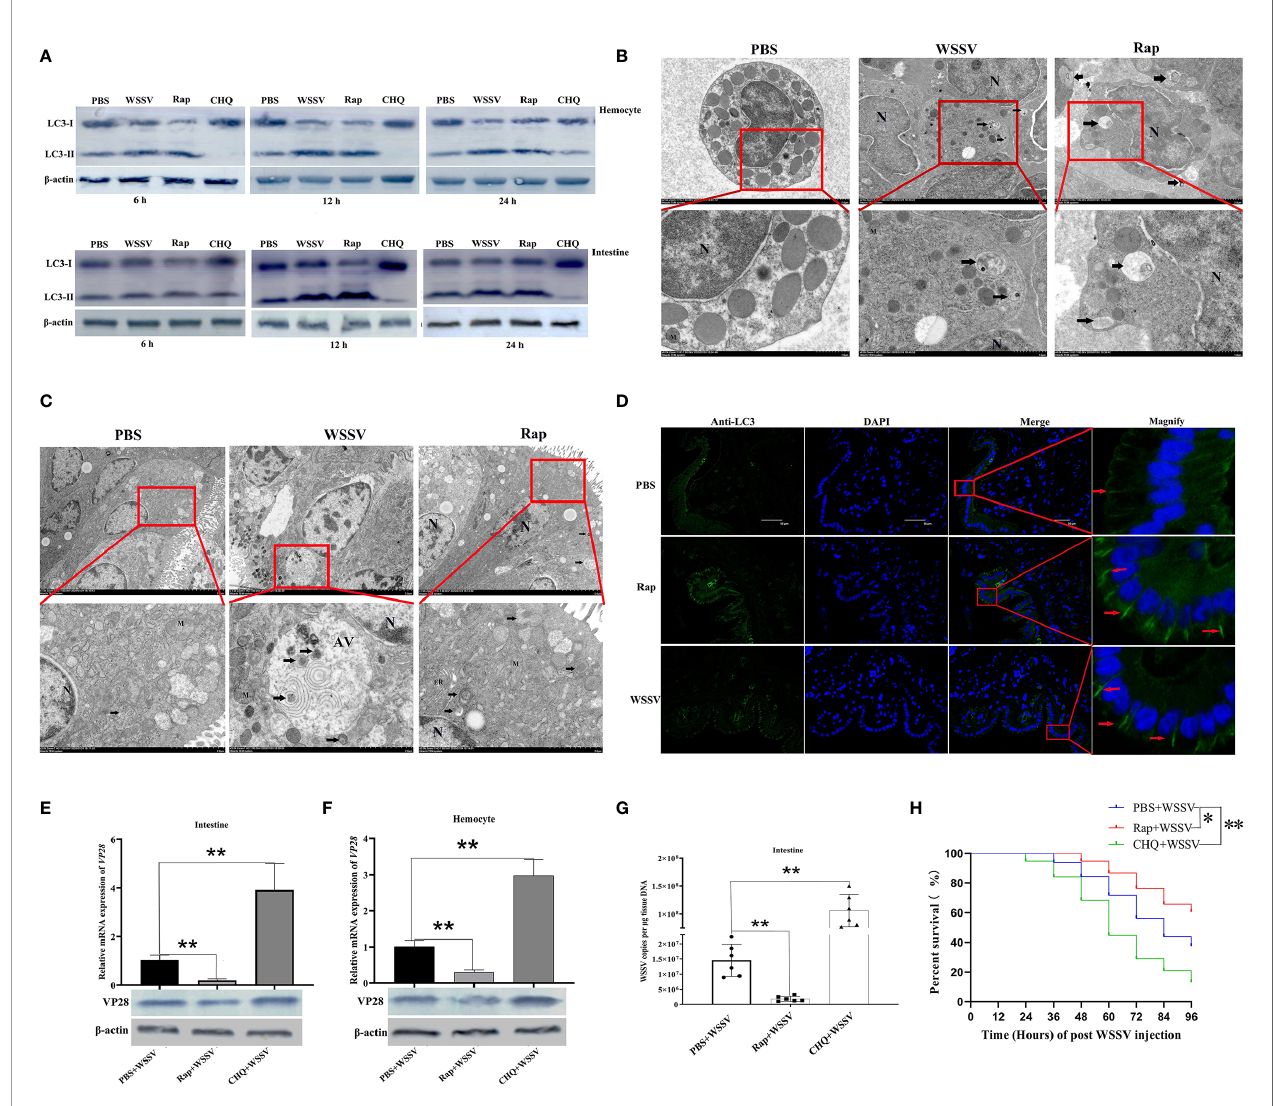
FIGURE 3 | Autophagy played a positive role in restricting WSSV infection in shrimp. (A) The expression of LC3-II/LC3-I in hemocytes (upper panel) and the intestine (lower panel) was detected by Western blotting. (B) The formation of autophagosome-like vesicles in hemocytes of PBS, WSSV, or Rap challenged shrimp was observed by TEM. Vesicles with the characteristics of autophagosomes are indicated by black arrows. N, nucleus; M, mitochondrion. (C) The formation of autophagosome-like vesicles in the intestine of PBS, WSSV, or Rap challenged shrimp was observed by TEM. Vesicles with the characteristics of autophagosomes are indicated by black arrows. N, nucleus; M, mitochondrion; ER, endoplasmic reticulum; AV, autophagic vacuole. (D) The distribution of the autophagy marker LC3 in the intestine of PBS, WSSV, or Rap challenged shrimp was detected by immunocytochemistry. Positive immunoreactivities of LC3 are indicated by red arrows. (E) The VP28 expression in the intestine of PBS+WSSV group, Rap+WSSV group, and CHQ+WSSV group was determined by using qRT-PCR (upper panel) and western blotting (lower panel). (F) VP28 expression in the hemocytes of PBS+WSSV, Rap+WSSV, and CHQ+WSSV groups was determined by using qRT-PCR (upper panel) and western blotting (lower panel). (G) Virus copy number in the intestines of PBS+WSSV, Rap+WSSV, and CHQ+WSSV groups was detected by qPCR. (H) The survival rates in PBS+WSSV, Rap+WSSV, and CHQ+WSSV groups were recorded. The survival rates were calculated and survival curves were presented as Kaplan-Meier plots. Differences between the two groups were analyzed with log-rank test using the software of GraphPad Prism 8.02. The experiments were repeated at least three times. Asterisks indicate signi fi cant differences * P< 0.05 and ** P <0.01